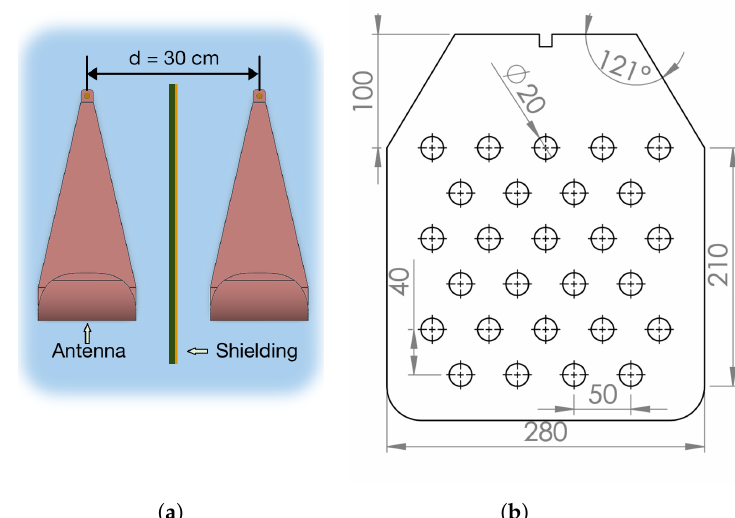
Figure 10. ( a ) Final antenna arrangement with separation of d = 30 cm; ( b ) detailed design parameters of the PCB shield (given values are expressed in